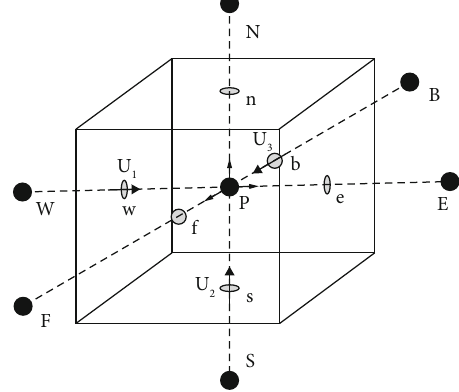
Figure 2: The description of the naming convention and location of variables used in the spatial discretization [30].